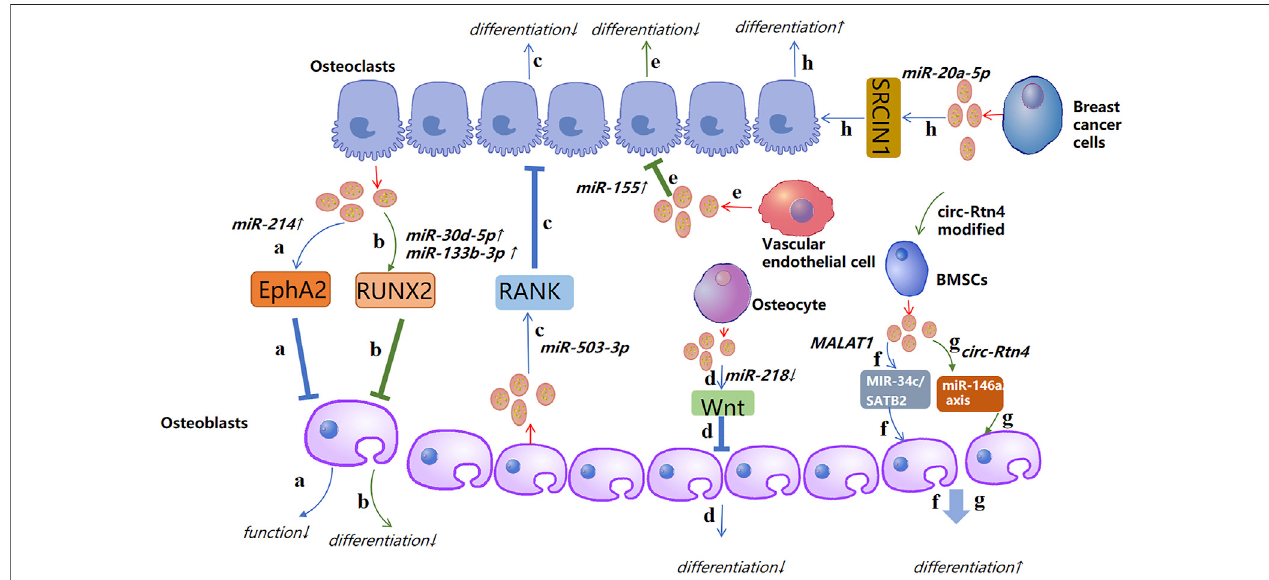
FIGURE4| Apossiblemechanismofactionofexosomalnon-coding RNAsinosteoporosis(schematic).Differentsourcesofexosomalnon-codingRNAs,suchas miRNA, lncRNA, circRNA, and tRNA, promote or inhibit the activity of osteoblasts and osteoclasts by regulating different targets, thereby affecting the course of osteoporosis. ↑ : promotion; ↓ :